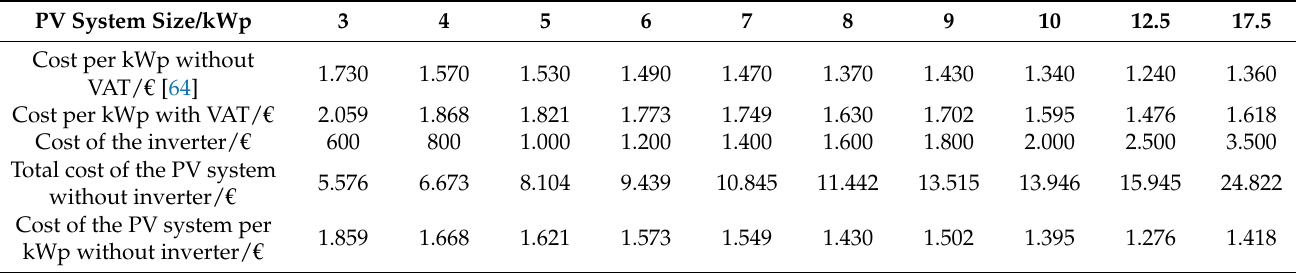
Table A1. Calculation of the PV system cost per kWp: Costs from Märtel [64] are used as the initial basis for calculating the PV system costs. These can be found in the table in row 1. The costs in the simulation needed only include the costs for the PV system including construction without the inverter. In the simulation the costs for the inverters are 200 € /kW. Thus, the cost of the inverter was deducted from the cost of Märtel. To obtain a simple functional relationship between the PV system size and the PV system cost, the values of 3 kWp and 9 kWp were omitted and the value of 17.5 kWp was corrected to a lower value of 1300 € /kWp. The omitted values are marked in red in the table. The coefficient of determination is 0.9513.